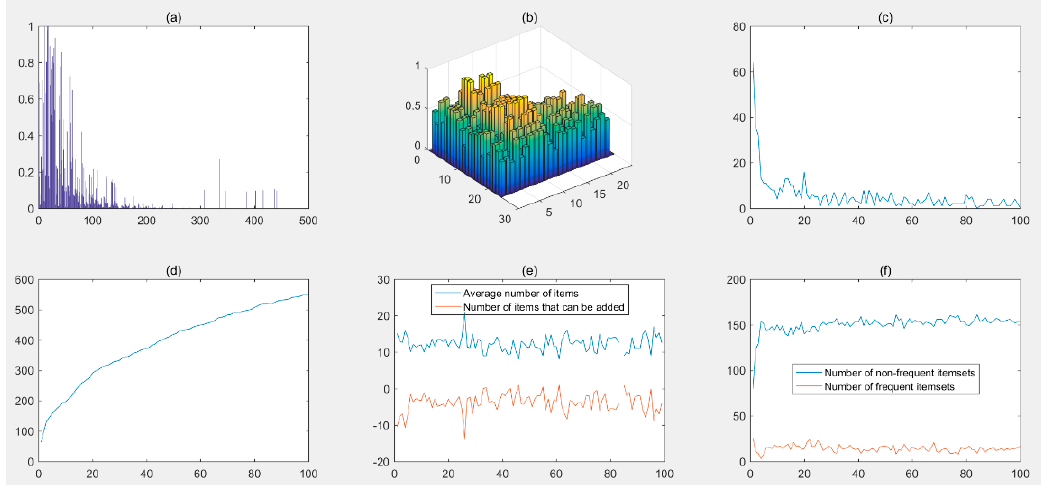
Figure 2. Results of transactions set accidents: ( a ) support of the corresponding item used as the 1-itemsets; ( b ) support of frequent 2-itemsets; ( c ) number of frequent itemsets against generation; ( d ) sum of frequent itemsets against generation; ( e ) average item number curve and addable item number curve against generation; and ( f ) number of infrequent itemsets curve and number of identical itemsets curve against generation.